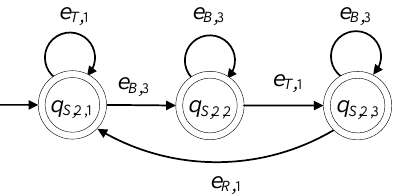
Figure 9. State diagram of S 2 .